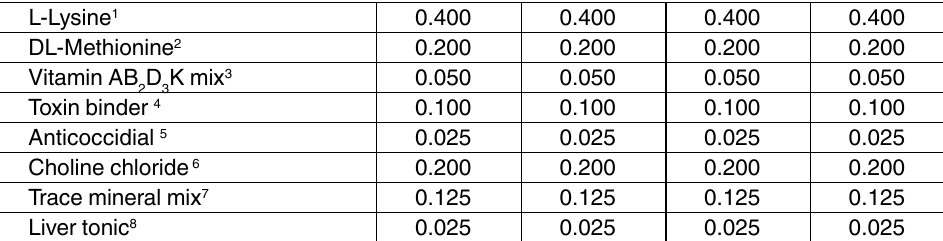
Table 4. Feed additives for starter and finisher diets, per